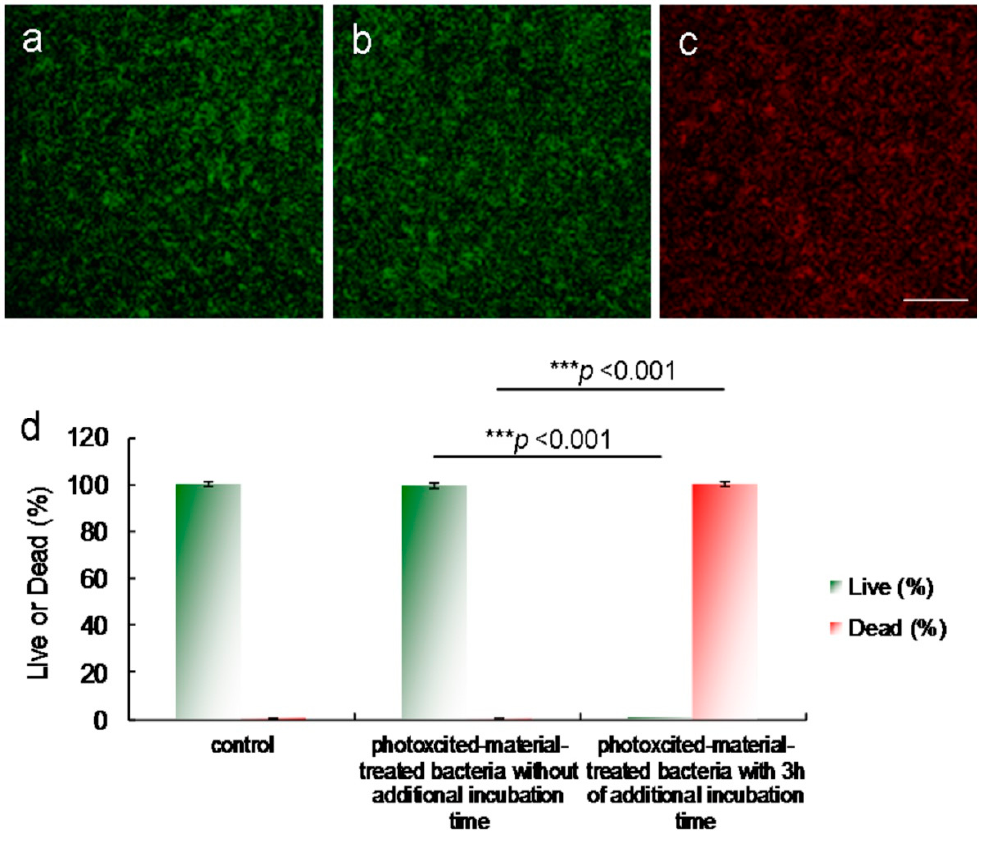
Figure 8. Images obtained after 60-s laser photoexcitation exposure (0.07 W·cm − 2 ; Ex: 670 nm) of ( a ) bacteria alone with 3 h of additional incubation, and amino-N-GQD-Ab protein A -treated MRSA ( b ) without additional incubation, and ( c ) with 3 h of additional incubation. The LIVE/DEAD kit was used to stain bacteria before images were captured. ( d ) Viability (%) determination results. For the percentages of live and dead bacteria, *** p < 0.001. * p value was obtained using the Student’s t test (* p < 0.05, ** p < 0.01, *** p < 0.001). Delivered dose: OD 600 = ~0.05 μ g·mL − 1 for bacteria and 0.5 μ g·mL − 1 for material–Ab protein A . Data are presented as mean ± SD ( n = 6). Scale bar: 50 μ m.